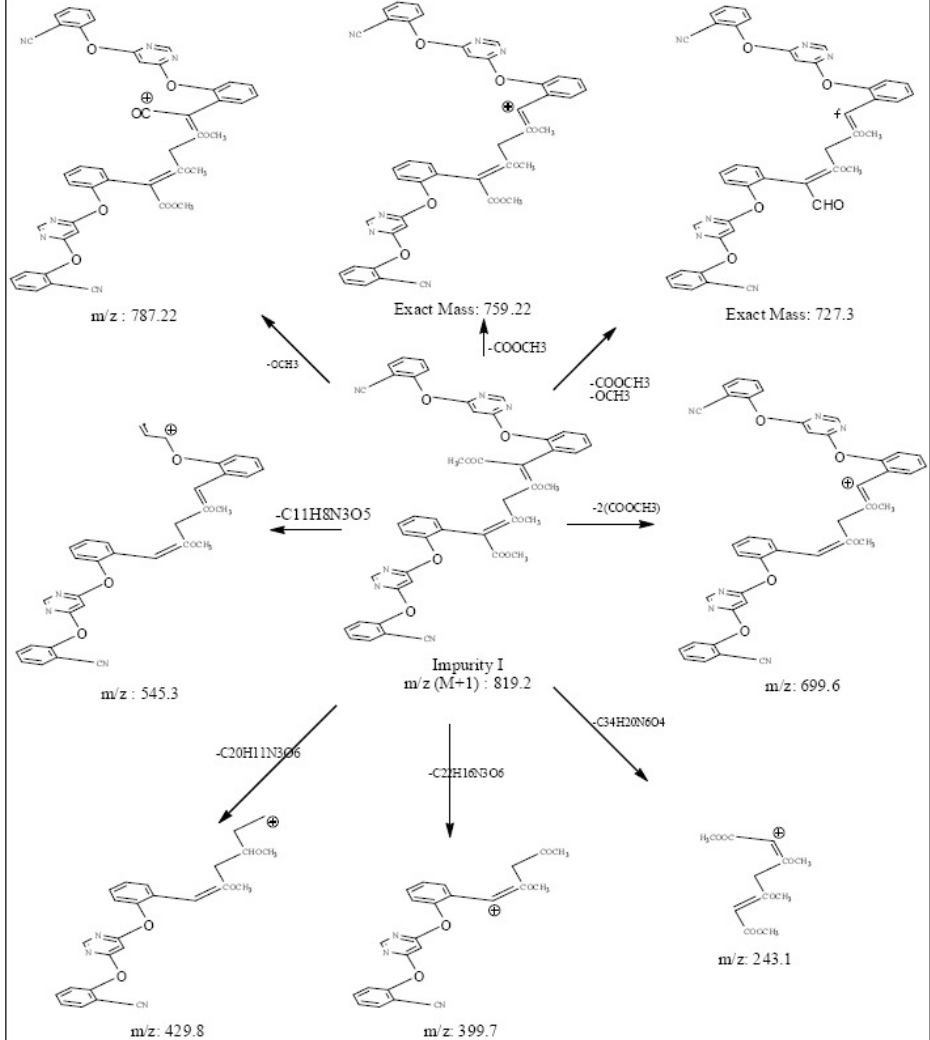
Figure 2. Mass fragmentation of impurity